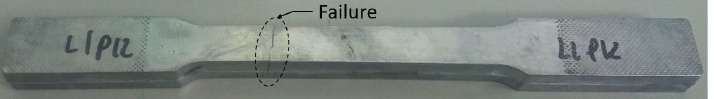
Figure 4. Crack in the specimen under test.